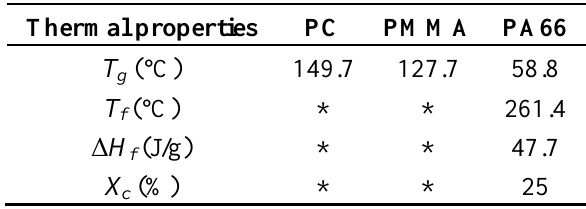
Table 2. Thermal properties of studied polymers